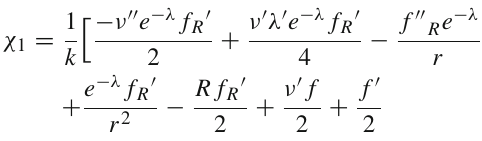
gravitational mass is used to discuss the stability of devel- oped frameworks. Our solutions leads to the construction of the models of highly compact spheres that are in the equilib- rium mainly due to pressure anisotropy. The factor (cid:19) is the measure that determines stability or instability in the gravitat- ing system and it interprets cracks or instabilities occurring in fluid distribution due to perturbations in the system. We have presented graphical representation of (cid:19) for three dif- ferent values of k in both the frameworks as Figs. 1 and 2 by considering a unit test sphere. It is clear from figures that value of omega do not change its sign that shows no cracking for both